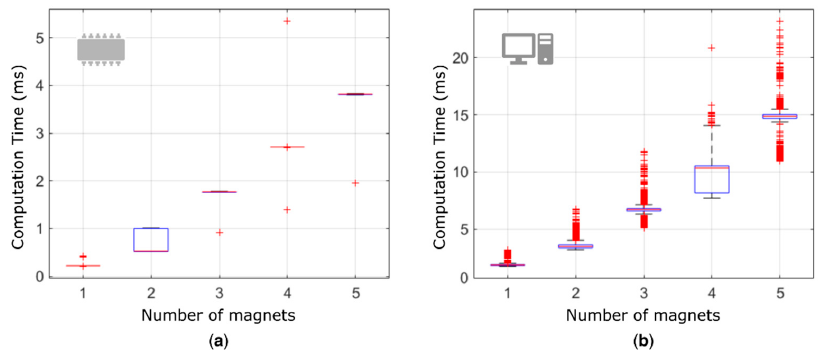
Figure 6. Computation times. CT in retrieving five magnets using the forearm mockup using the embedded ( a ) and desktop ( b ) implementations.